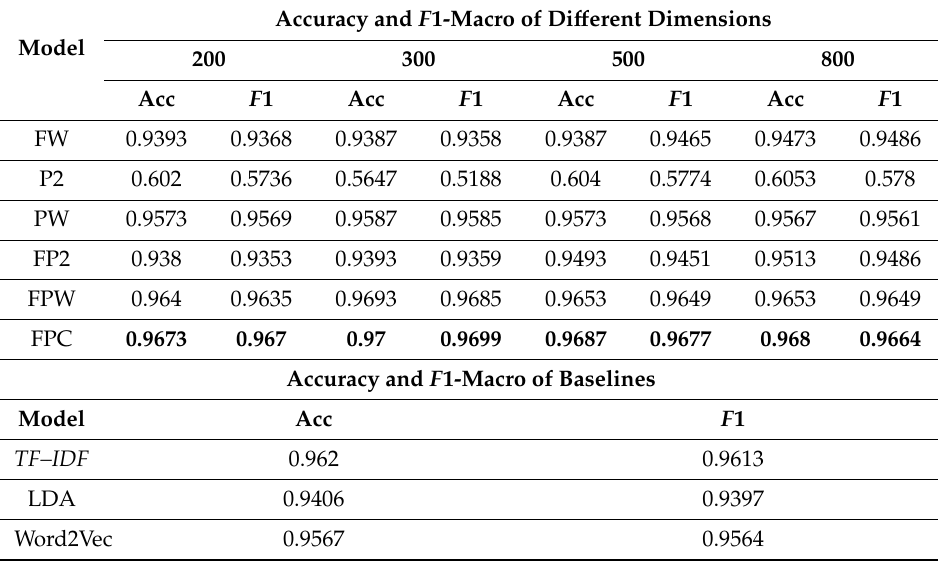
Table 6. Results of FudanNLP in three classes for 1500 texts by